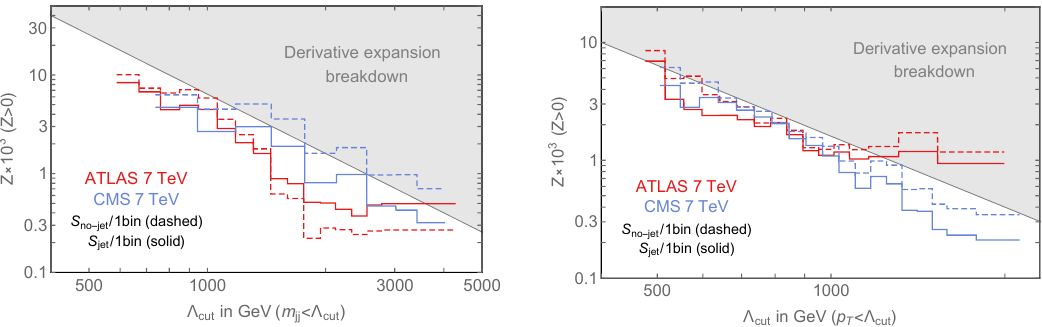
Figure 6 . 95% CL bounds on Z from the 7 TeV ATLAS and CMS analyses described in the text, as a function of (cid:3) cut . For a given value of (cid:3) cut only events with m jj < (cid:3) cut for dijets (left panel) or p T < (cid:3) cut for inclusive jets (right panel), are used to extract the limit. The gray area is de(cid:12)ned as Z > m 2 = (cid:3) 2 for dijets and Z > m 2 = (4(cid:3) 2 ) for inclusive jets, and roughly corresponds to cut cut W W